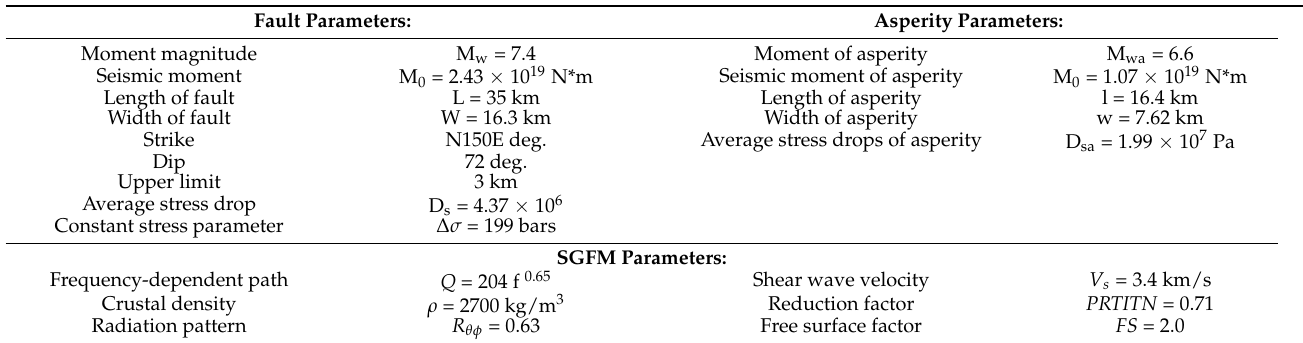
Figure 11. Locations of Emeelt fault model and site A–C. Table 9. Input fault parameters and properties for